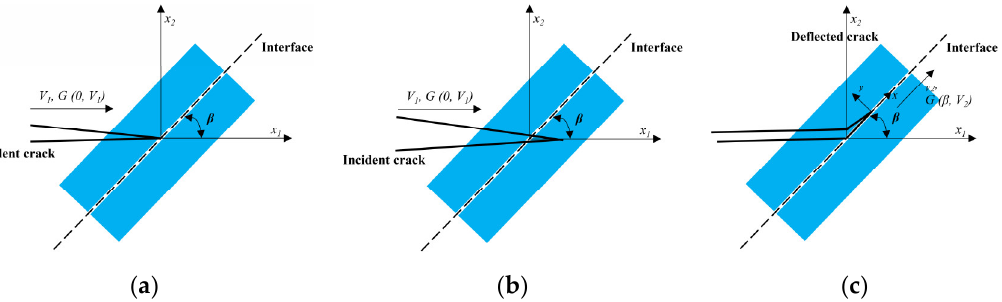
Figure 18. Schematic diagram of three crack growth modes: ( a ) Crack stops on the weak interface between two identical homogeneous solids; ( b ) crack goes through the weak interface between two identical homogeneous solids; ( c ) crack defects the weak interface between two identical homoge- neous solids.